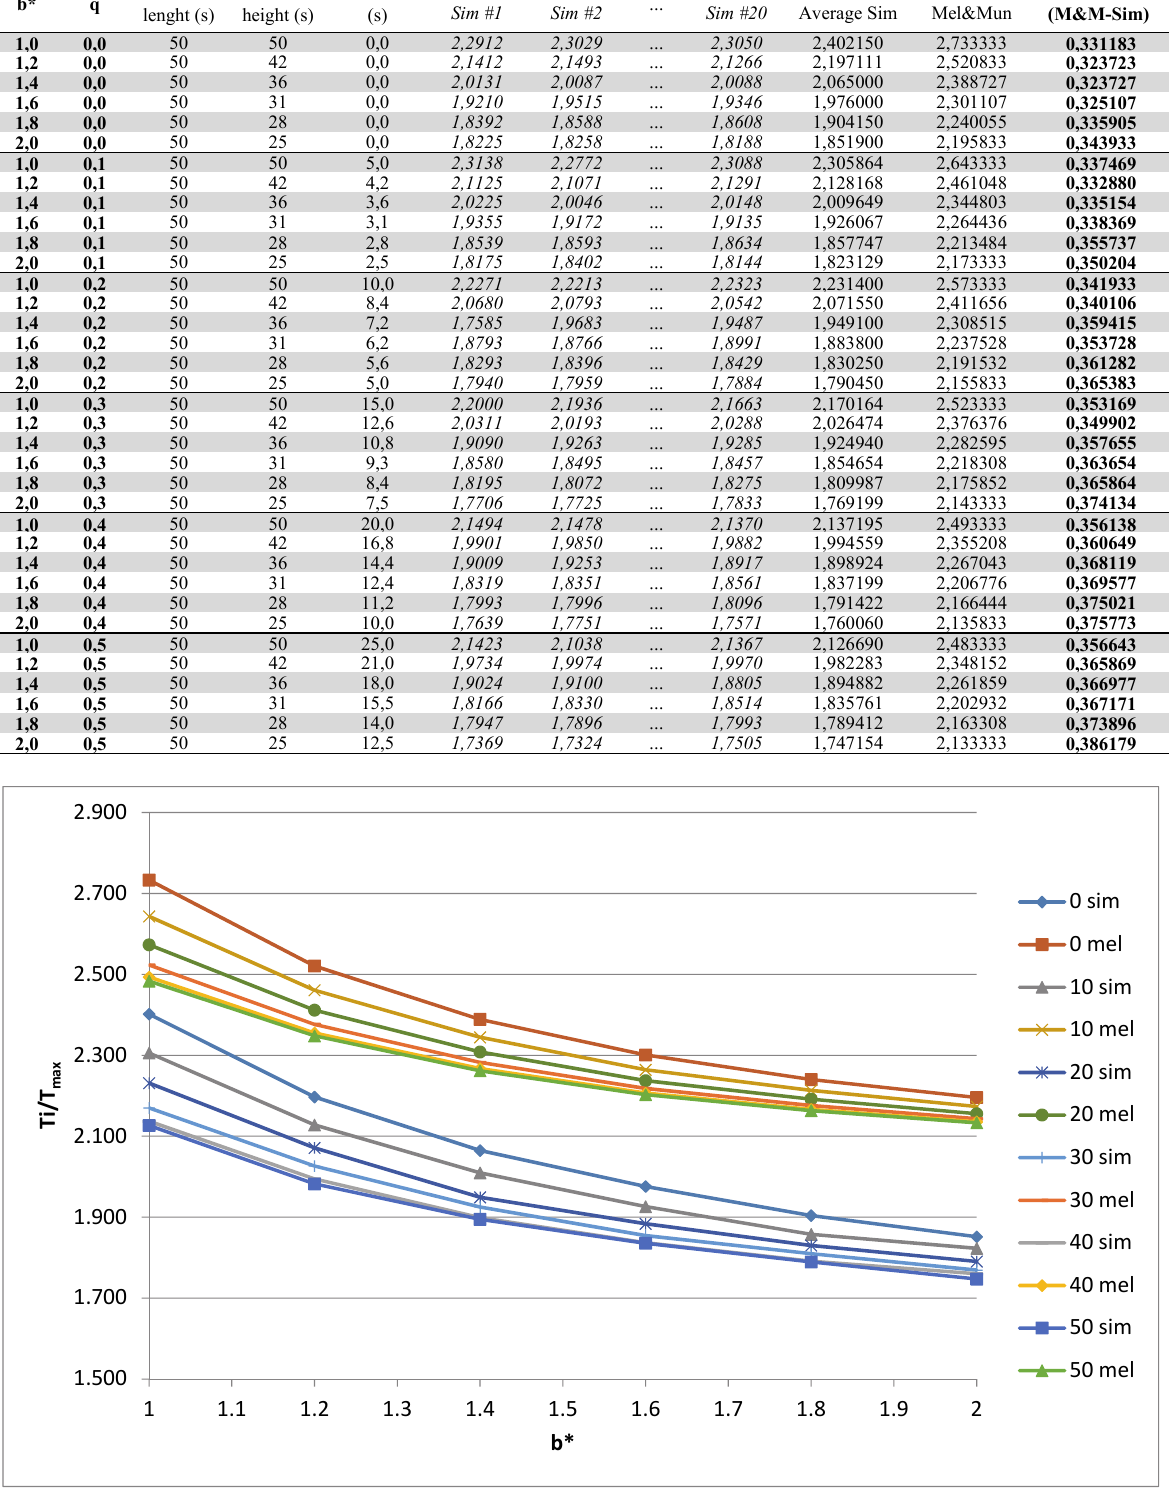
Fig. 3. Comparison between simulation and Meller and Mungwattana’s formula